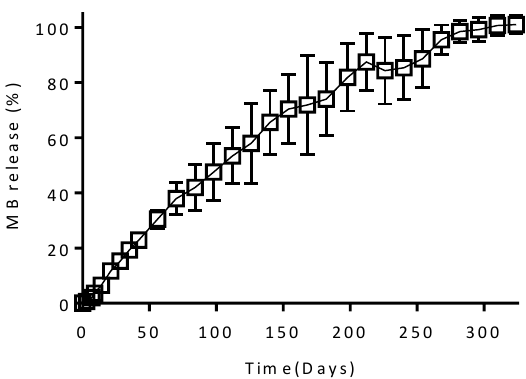
Figure 9. Release profile of methylene blue from Implant B with a PCL formulation coating ( n = 3, means ± SD).